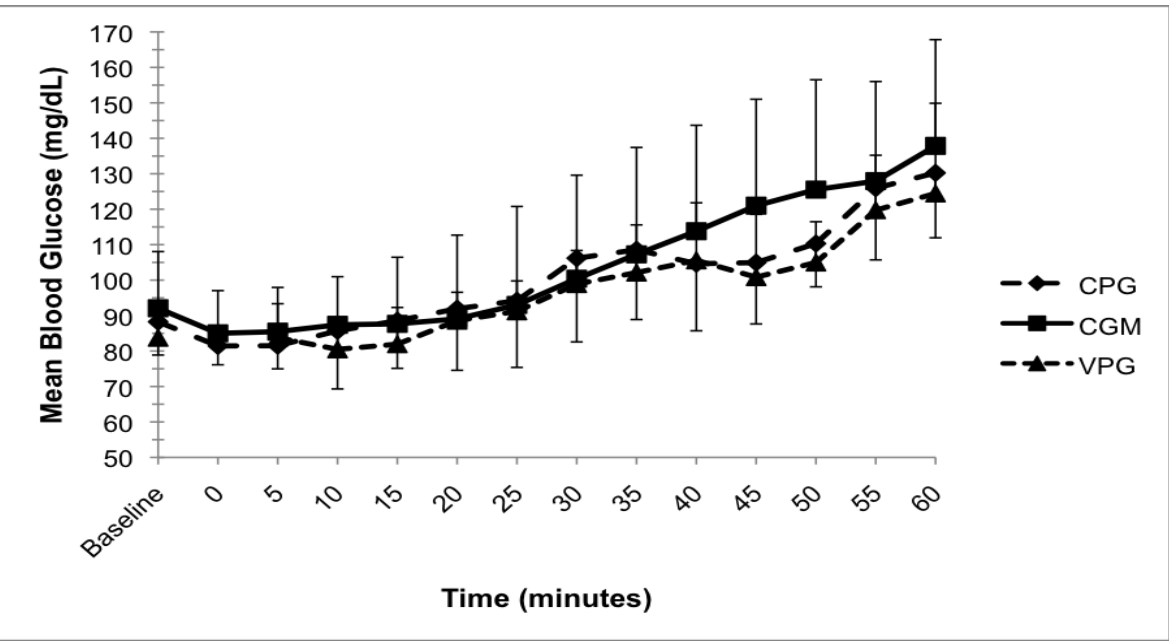
Figure 1. Effect of exercise and carbohydrate supplementation on glucose response during 45 min of steady-state moderate-intensity cycling and 15 min of recovery, performed by healthy females in a study to determine the comparability of three glucose monitoring methods. Average glucose values for each measurement method taken at 5 min intervals. VPG = Venous plasma glucose, CGM = Continuous glucose monitoring; CPG = Capillary plasma